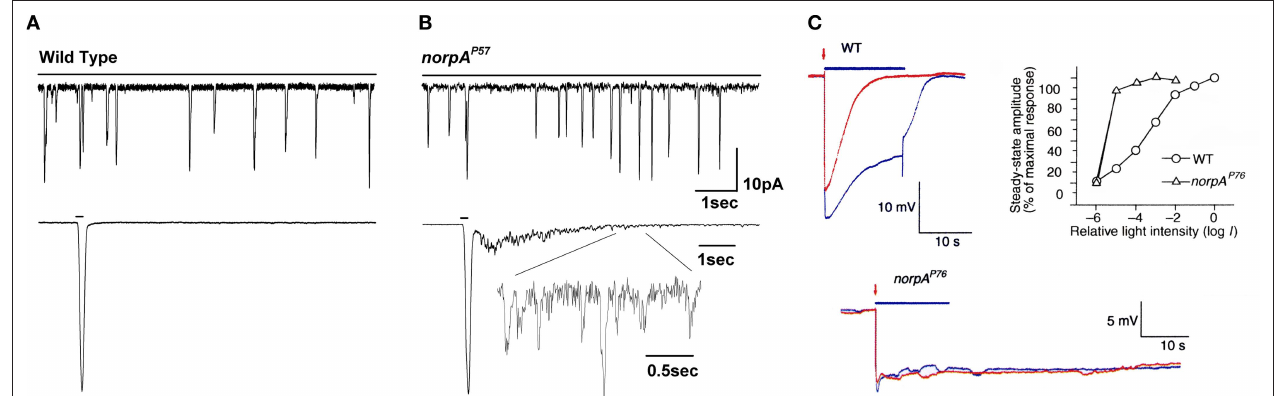
FIGURE 8 | Slow response termination composed of bumps characterizes norpA mutants. (A,B) Upper panels: Whole-cell voltage clamp recordings of quantum bumps in response to continues dim light in wild-type and the weak allele of norpA , norpA P57 mutant fl ies. (A,B) Lower panels: Whole-cell voltage clamp recordings of normalized macroscopic responses of wild-type and the corresponding mutants in response to 200-ms light pulses. In contrast to the fast response termination of wild-type, slow termination of the light response of norpA P57 mutant fl ies is revealed.